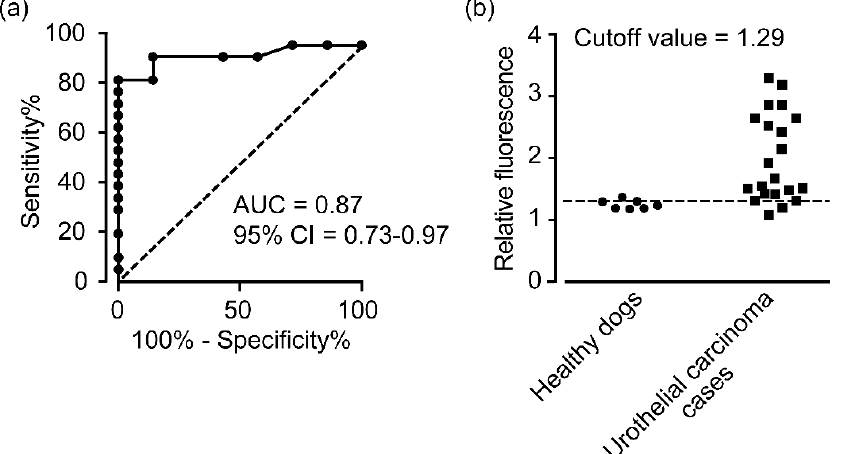
Figure 3. ( a ) ROC curves for the fluorescence intensity of 5-ALA in healthy dogs ( n = 7) vs. urothelial carcinoma cases ( n = 21). AUC—area under the curve. ( b ) The cutoff value was calculated by ROC curve analysis. Fluorescence intensity is expressed as a ratio of the fluorescence in the 5-ALA supplemented group relative to the fluorescence in the vehicle group for each sample. The horizontal dot line indicates the cutoff value.